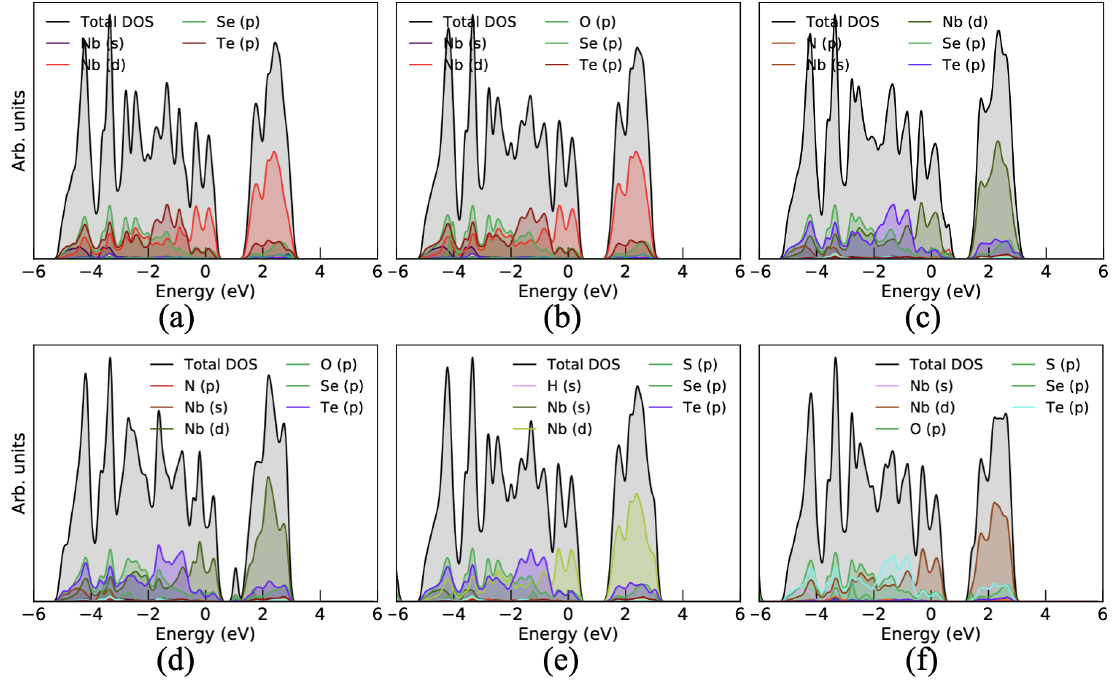
Figure 4. Projected density of states (PDOS) influenced by the toxic gas molecules adsorbed on the surface of the Janus NbSeTe monolayer with top and side view. ( a ) CO, ( b ) CO 2 , ( c ) NO, ( d ) NO 2 , ( e ) H 2 S, and ( f ) SO 2 gas molecules adsorbed on the Se-side of the Janus NbSeTe